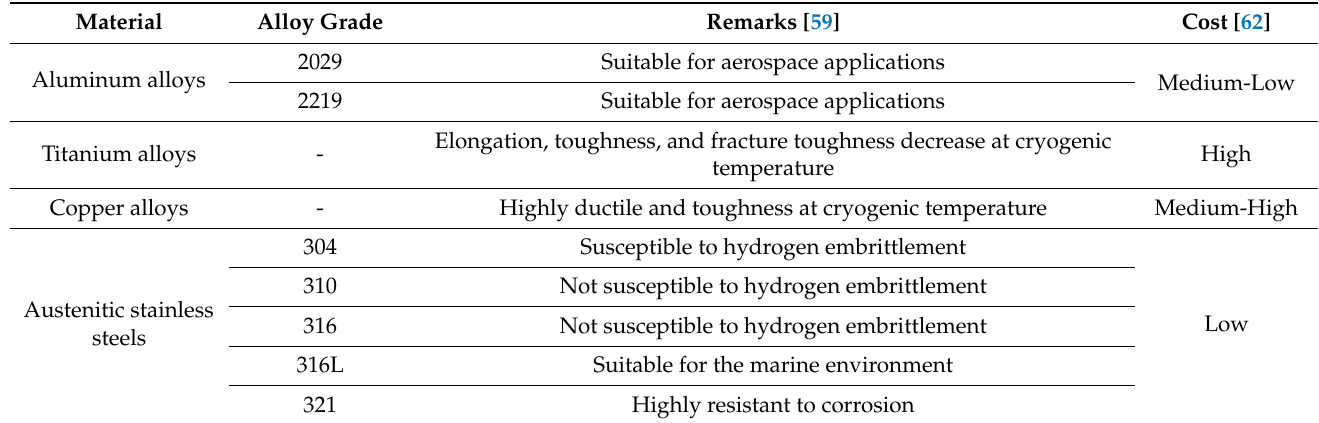
Table 3. Materials suitable for liquid hydrogen